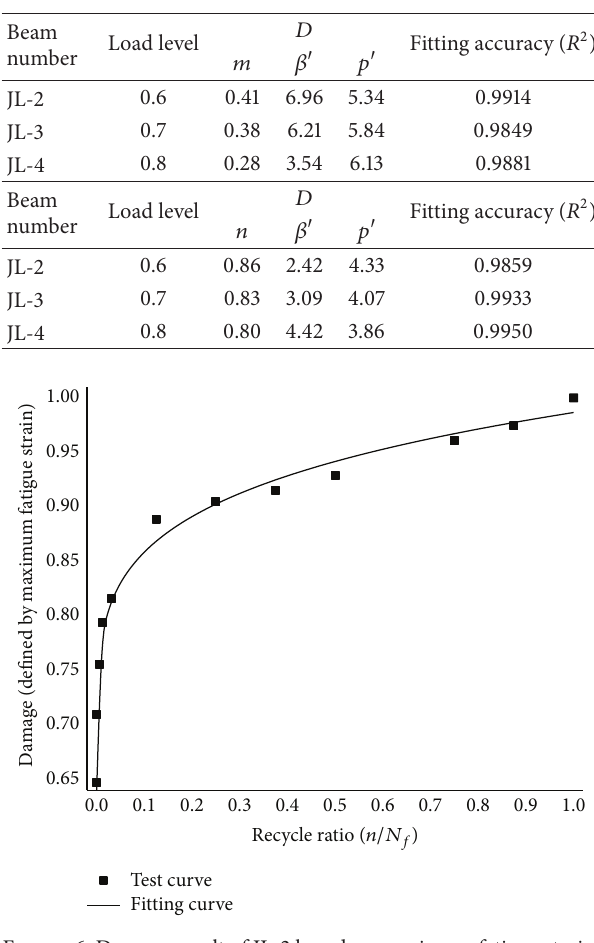
Table 5: Fatigue damage evolution equation coefficients.